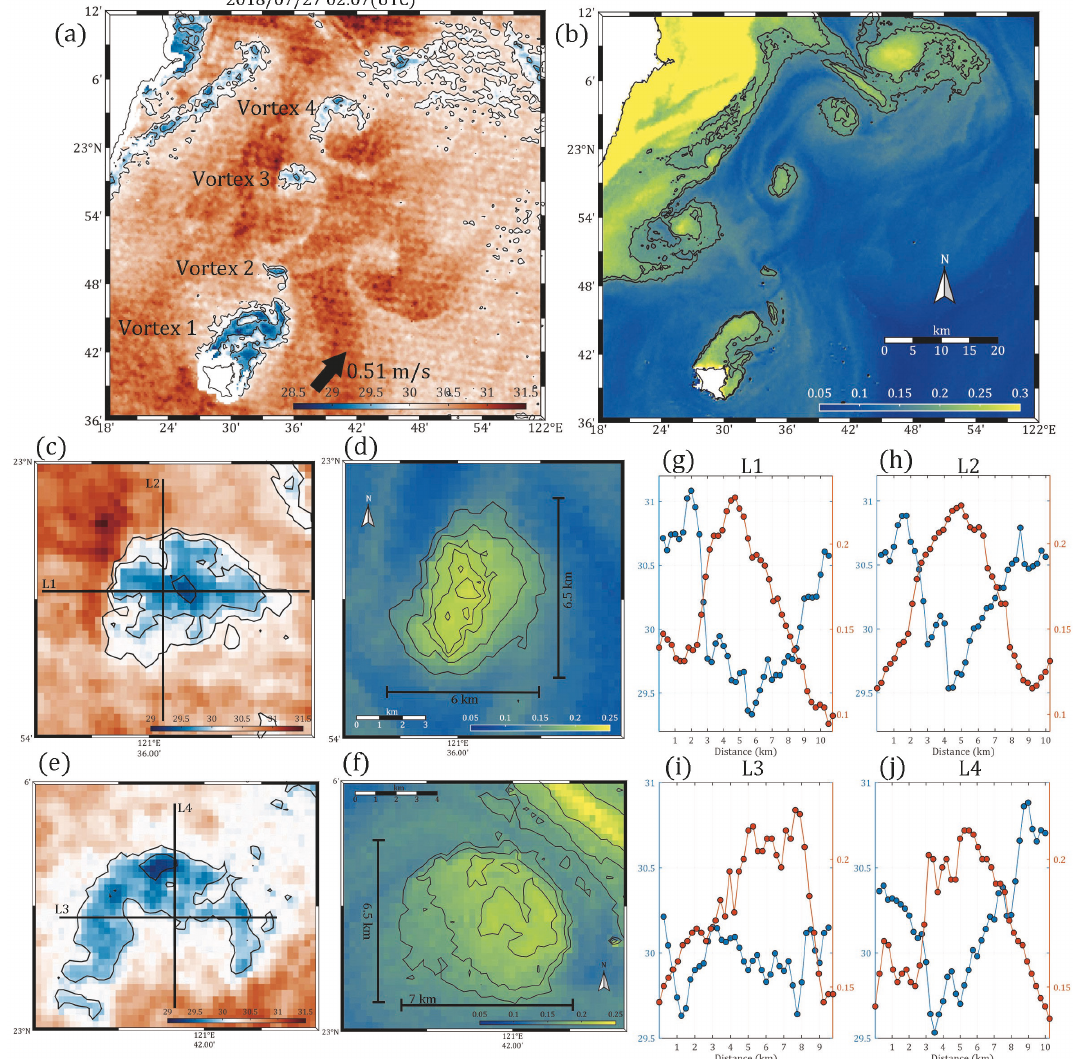
Figure 8. Case of the island vortex train with ( a ) SST ( ◦ C) and ( b ) Chl-a (mg/m 3 ) obtained from GCOM-C SGLI data taken at 02:07 (UTC), 27 July 2018 (UTC). ( c , d ) are zoom in on SST and Chl-a of vortex 3. ( e , f ) same as ( c , d ), but for vortex 4. ( g – j ) are SST and Chl-a values of L1 to L4. The black arrow (22.67° N, 121.67° E) in ( a ) is the current velocity from the OSCAR data with a speed of 0.51 m/s.